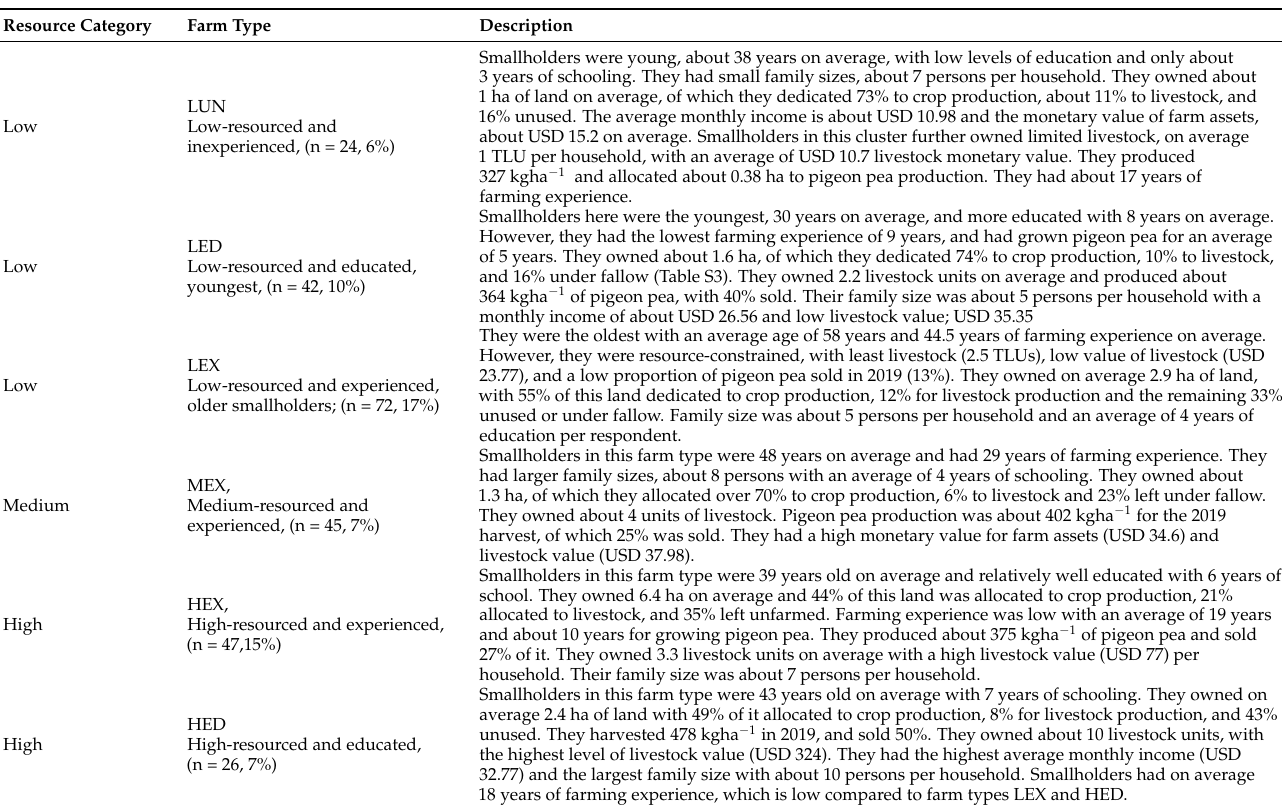
Table 2. Description of farm types of pigeon-pea smallholders in northern Uganda obtained from hierarchical cluster